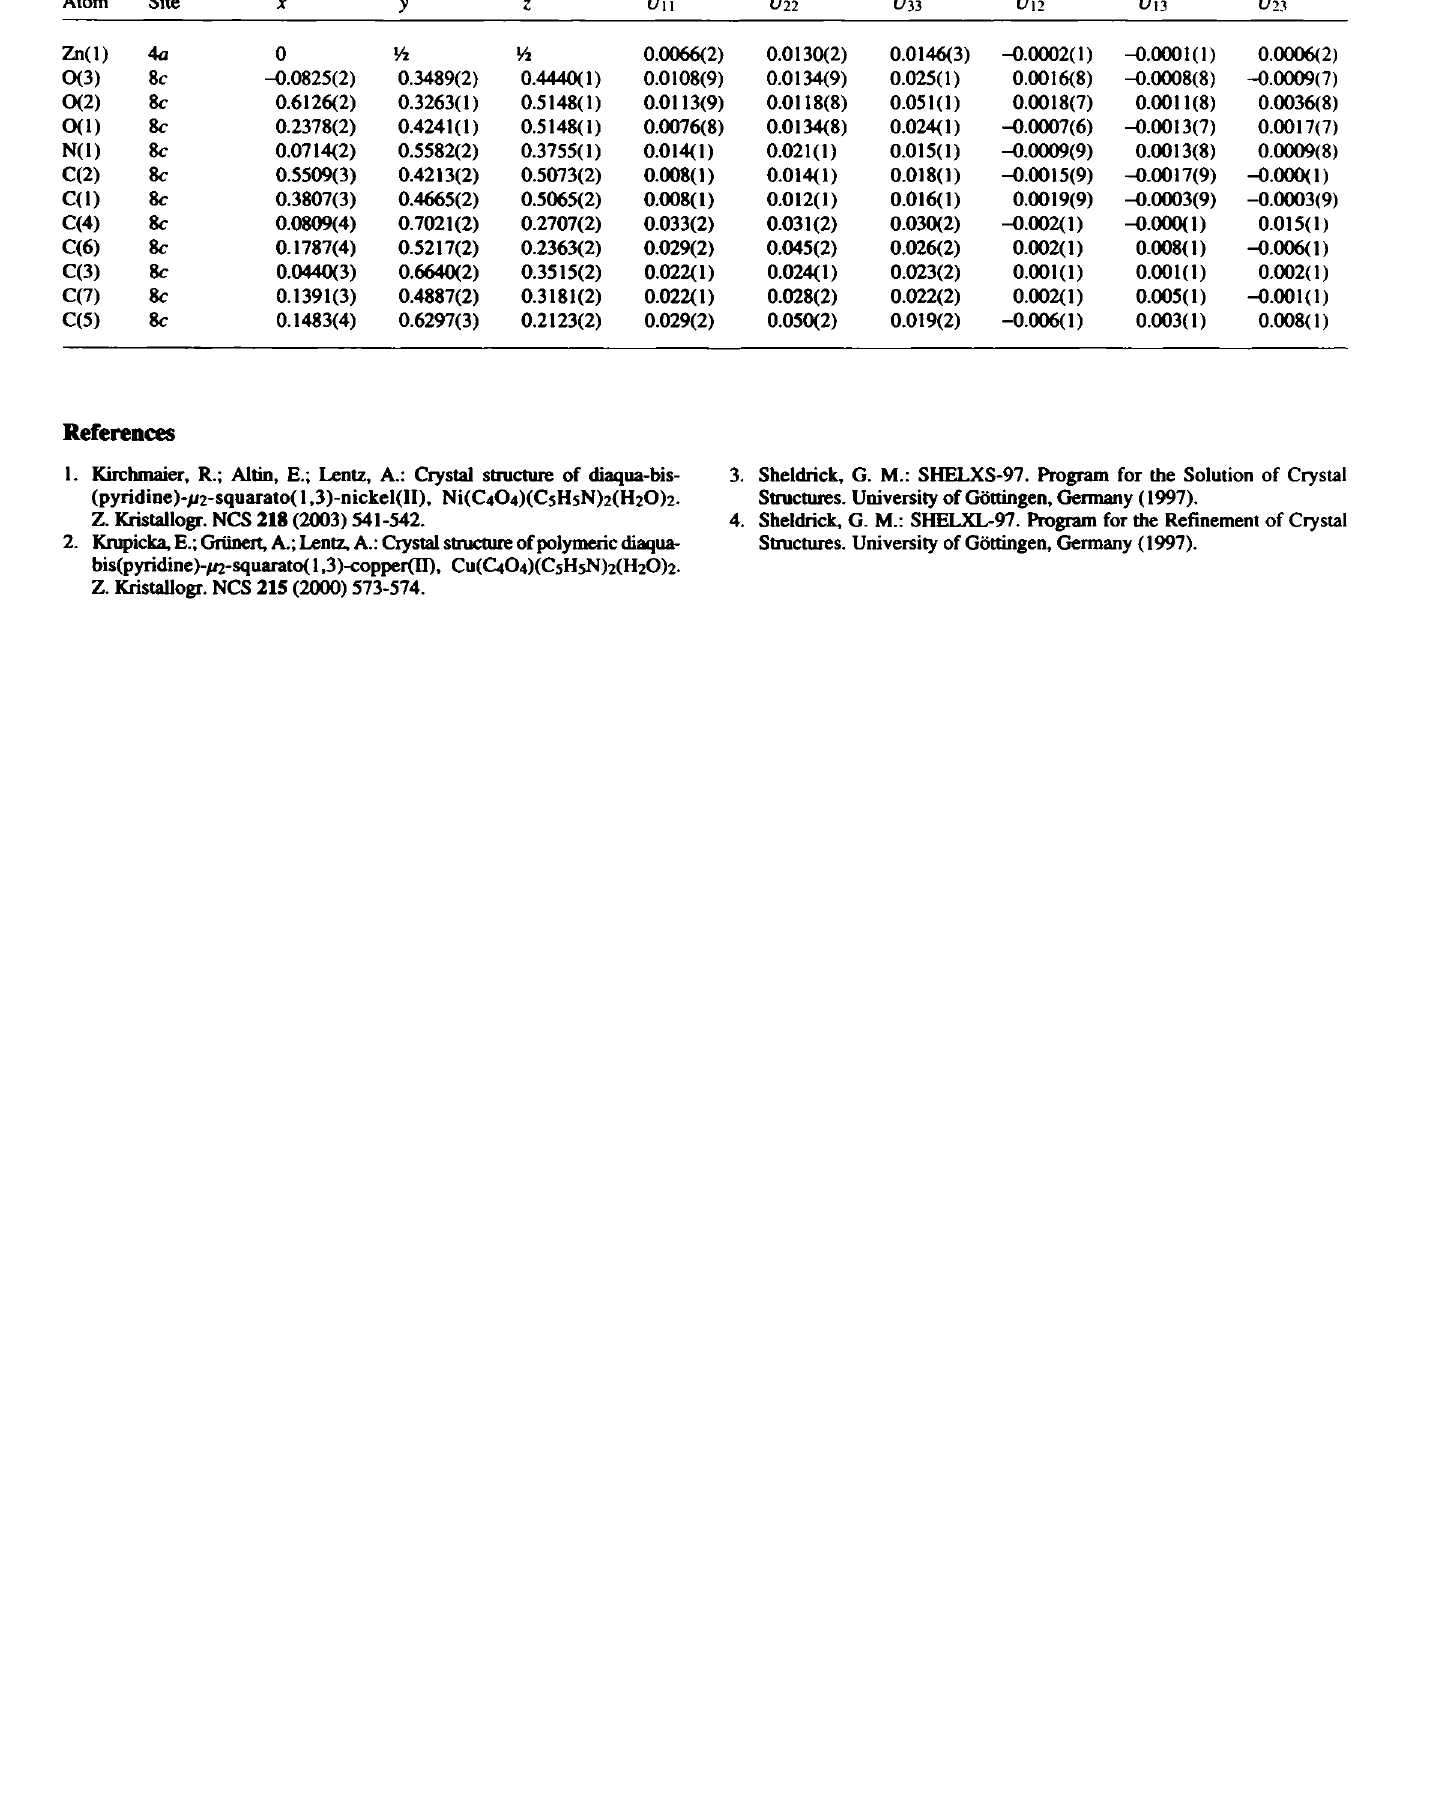
Table 3. Atomic coordinates and displacement parameters (in À 2